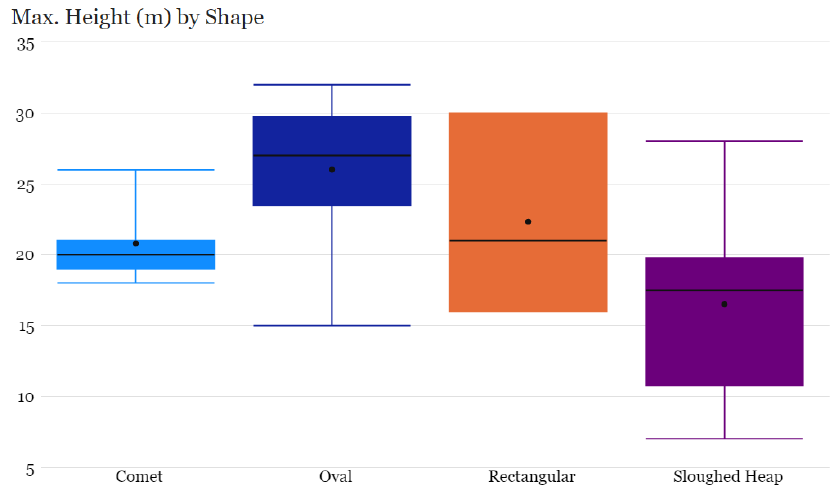
Figure 4. Box Charts of Max. Height (m) by Dump Profile Shape.